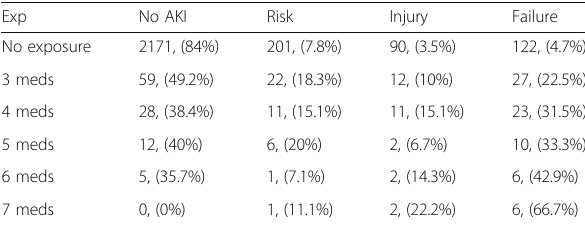
Table 101 (abstract A322). Cumulative nephrotoxin exposure and